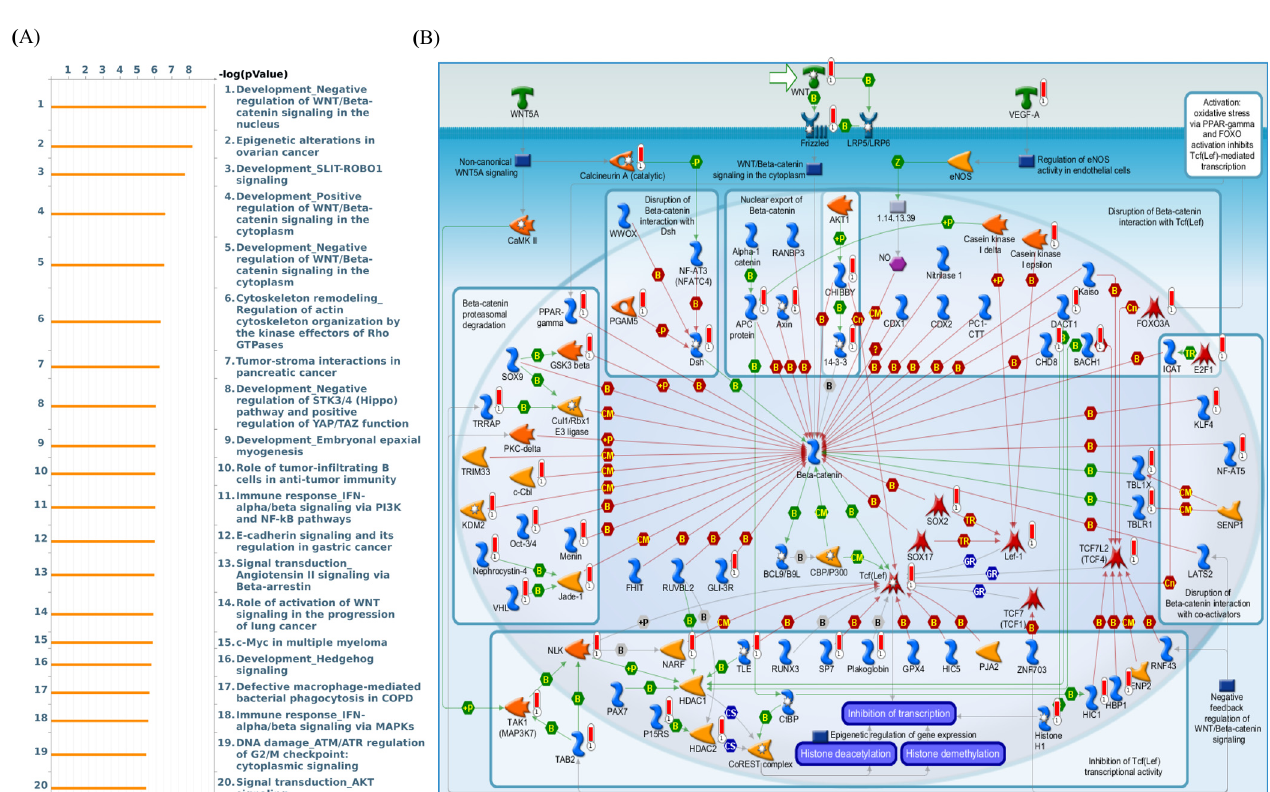
Figure 6. ( A ) In order to define the network of potential genes and related pathways affected by input genes, we exported LAGE2A co-expressed genes from TCGA and METABRIC breast cancer datasets to the MetaCore pathway analytical tool. ( B ) The result of MetaCore pathway analysis of “biology processes” illustrated that “development negative regulation of WNT/Beta catenin signaling” in the nucleus-related pathway was correlated with breast cancer development.